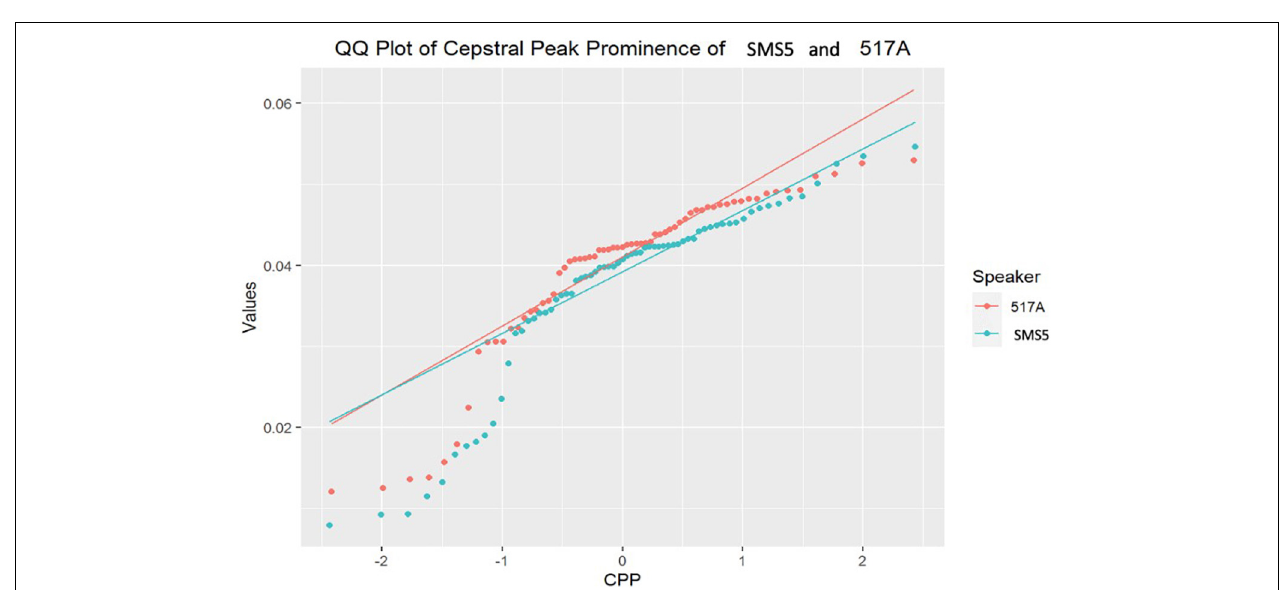
FIGURE 4 | Q–Q plot of SMS5 and 517A cepstral peak prominence (CPP) distributions.